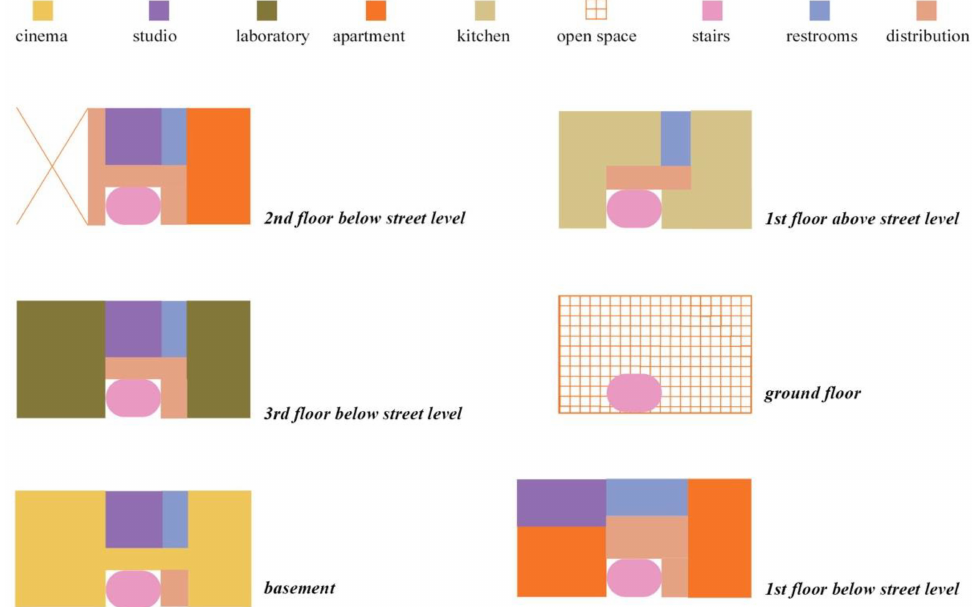
Figure 7. Definition of a reuse